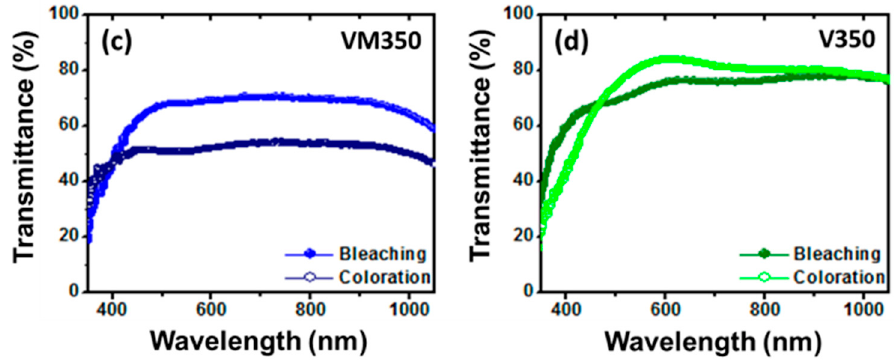
Figure 5. Transmittances of MoO 3 /V 2 O 5 hybrid nanobilayers heated at 350 °C for 2 h in air. ( a ) M350, ( b ) MV350, ( c ) VM350, ( d ) V350.